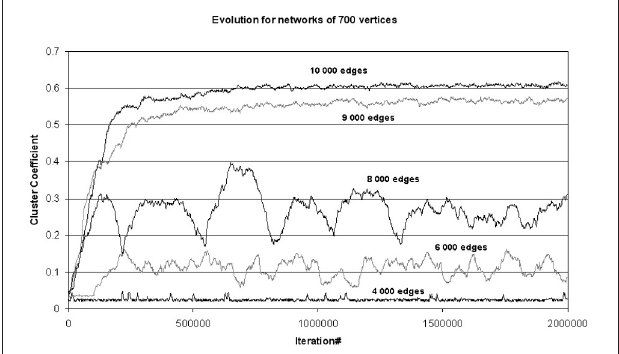
FIGURE 2 | Self-organization from random to small-world critically in a network of 700 vertices. The self-organization occurs through adaptive rewiring. Whether a small-world emerges depends on the number of